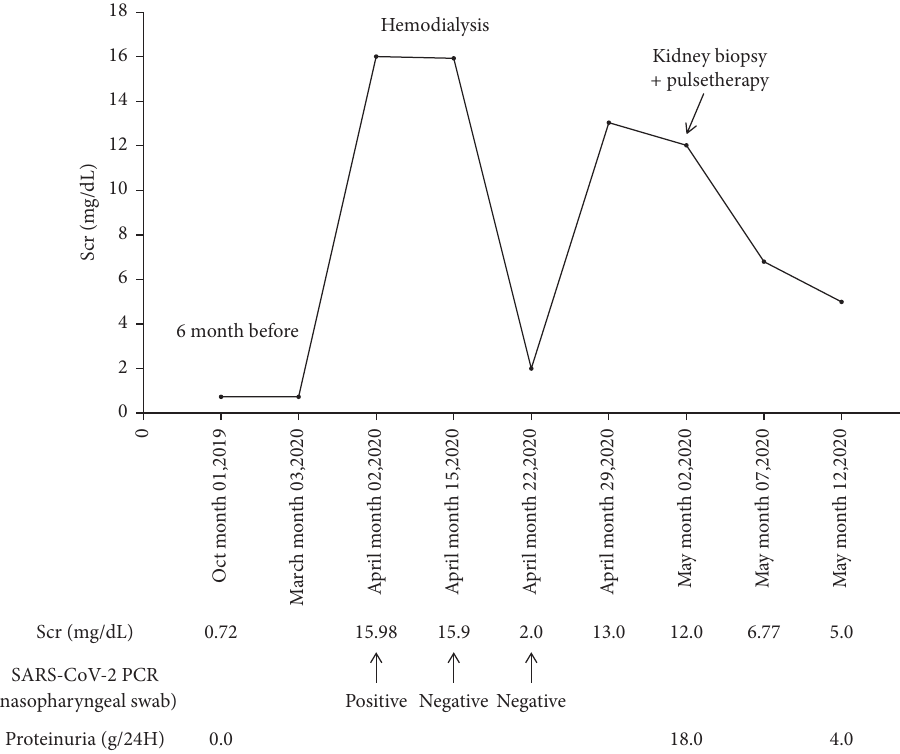
Figure 2: Changes in serum creatinine and proteinuria with time in a 48-year-old African male admitted for acute kidney injury with